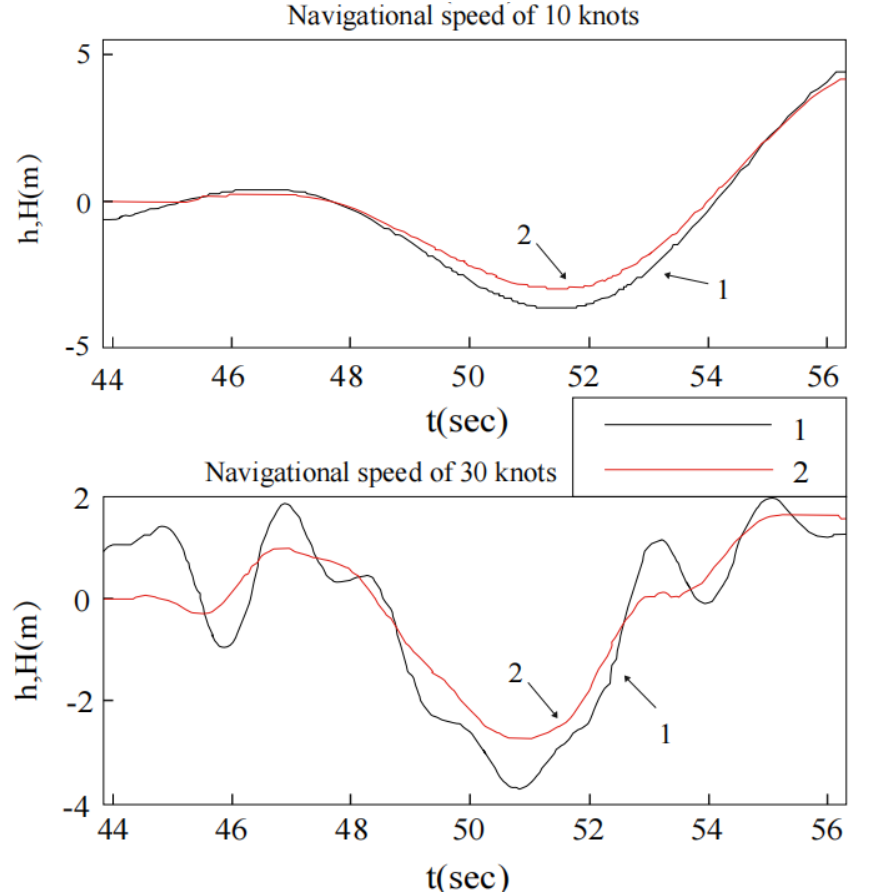
Figure 16. The response curves of carrier aircraft tracking vertical motion of ideal landing point under different navigational speeds.